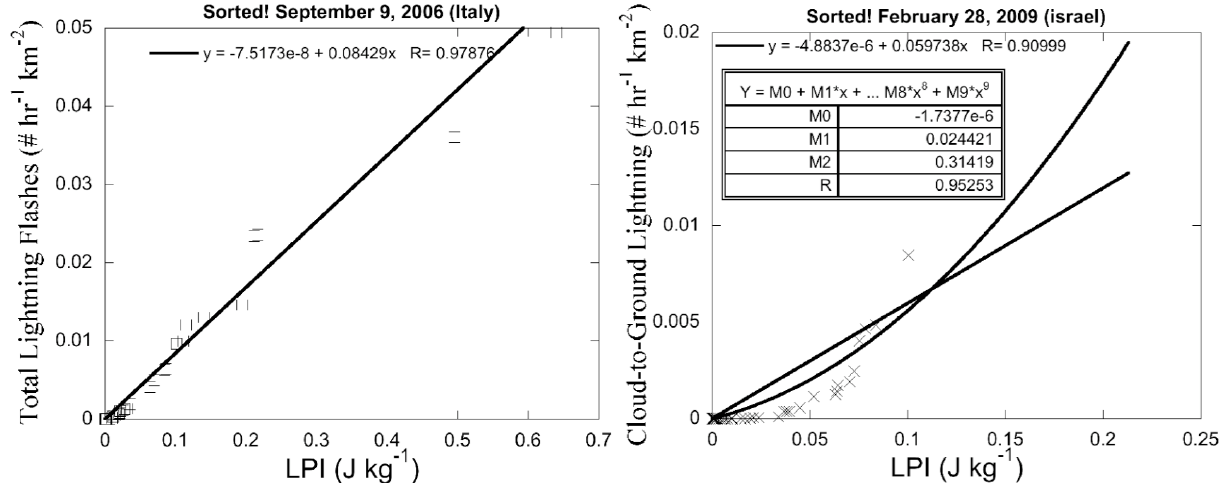
Fig. 3. Lightning versus LPI for the two case studies Italy (left) and Israel (right) averaged for 36km grid points.